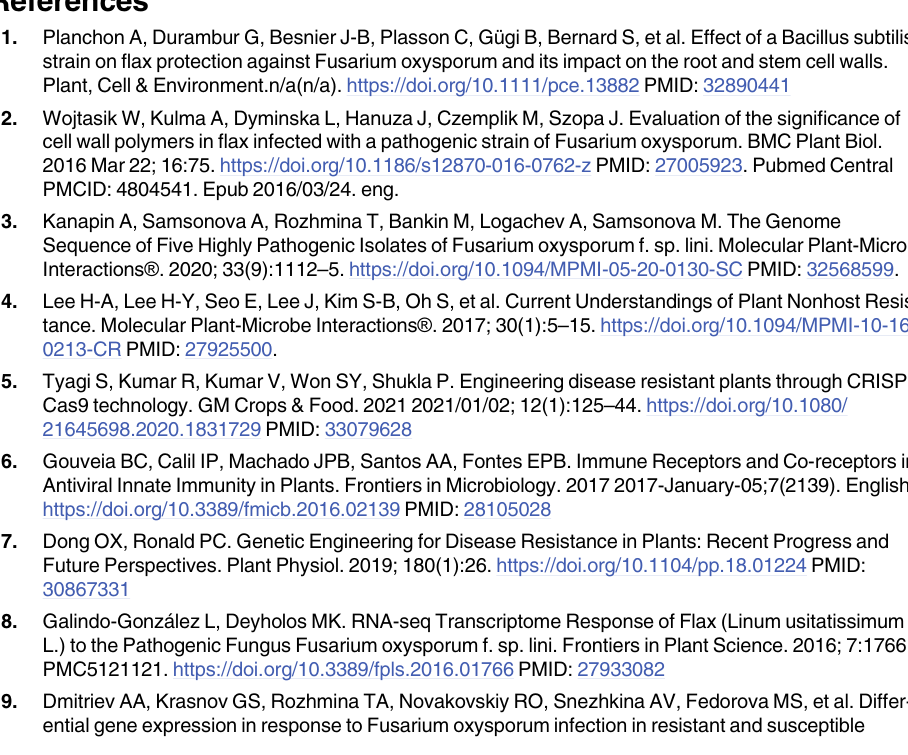
S5 Table. Nike treated with pathogen vs Nike non-treated (control) at 48 hpi. S6 Table. Regina treated with pathogen vs Regina non-treated (control) at 24 hpi. S7 Table. Regina treated with pathogen vs Regina non-treated (control) at 48 hpi. S8 Table. DEG number of GO terms